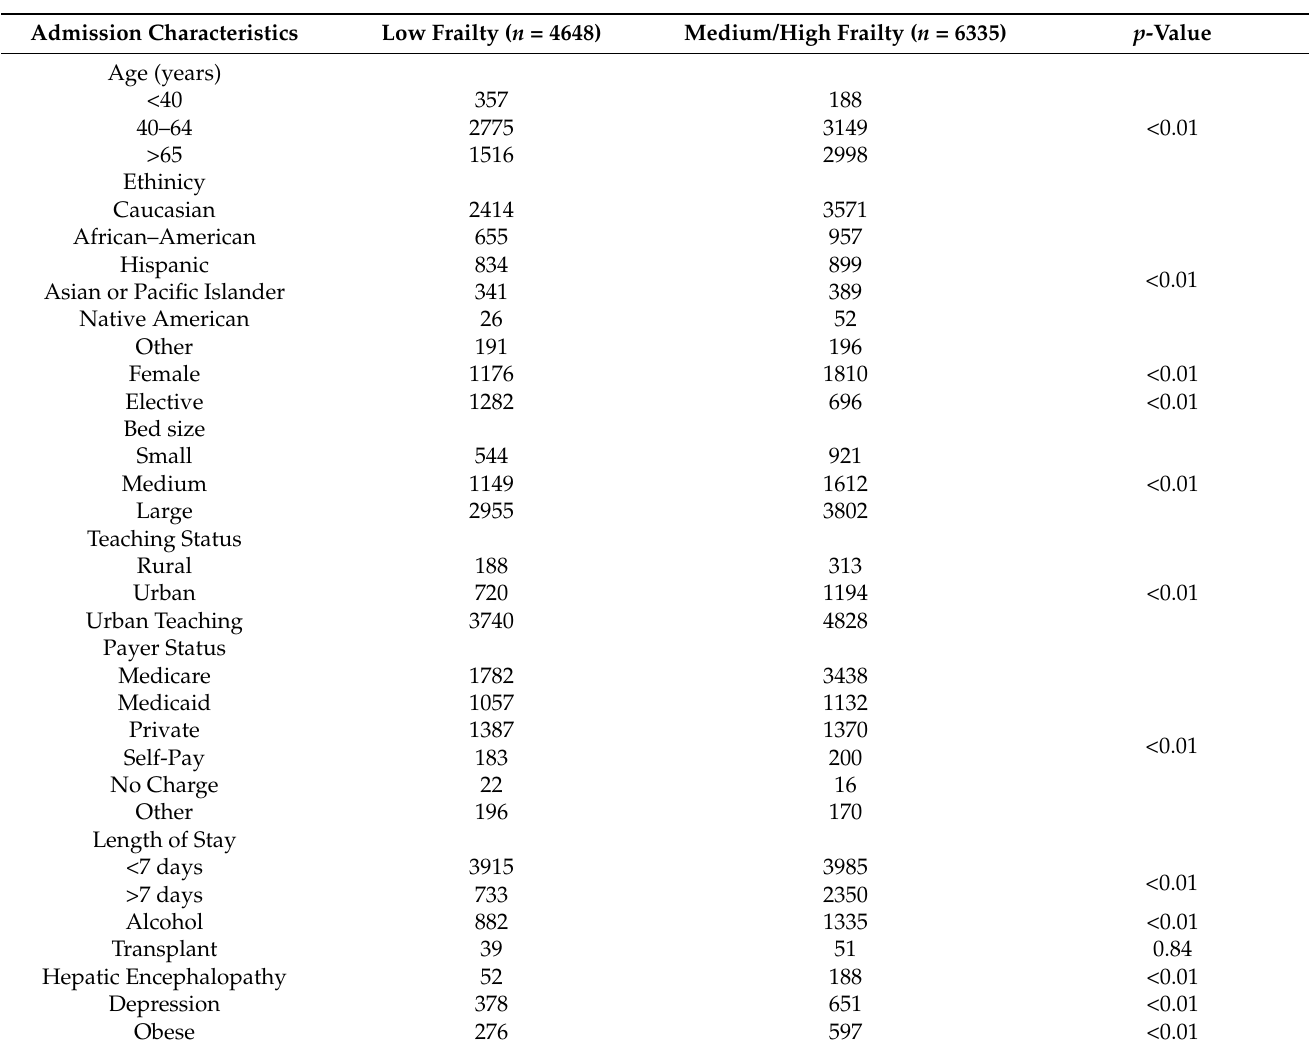
Table 1. Baseline